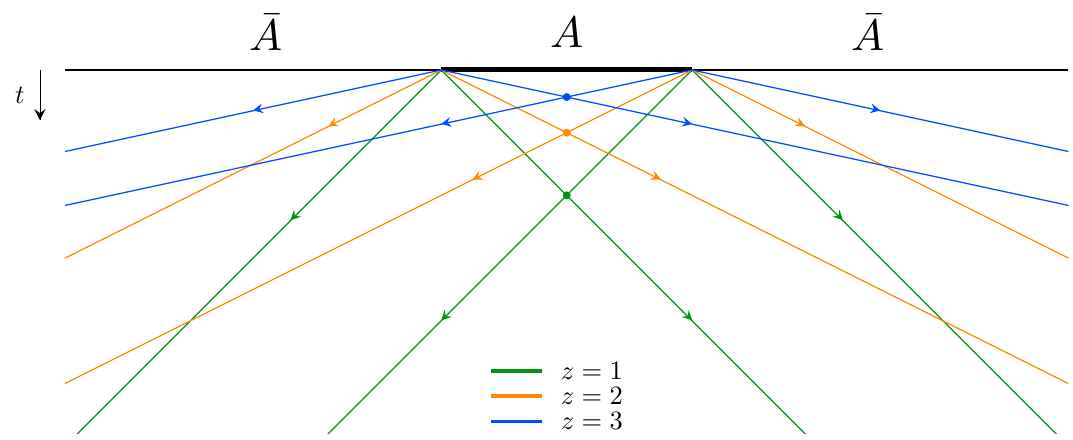
Figure 9 . Here A is the entangling region and (cid:22) A is the complement. The widen light-cones for di(cid:11)erent values of dynamical exponent are shown. The green lines are the standard (Lorentzian) light rays with v max (1) = 1 and the orange and blue ones correspond to higher dynamical exponents g which the cone gets wider. The speci(cid:12)ed points in the middle of the region along the time direction are f t max